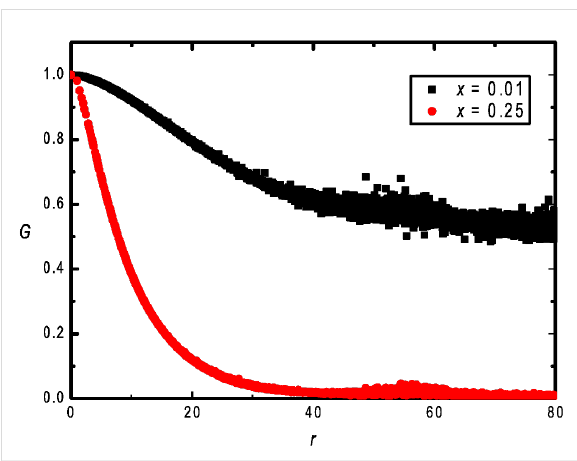
Figure 1: Nematic orientational correlation function G ( r ) for different values of x ( x = 0.01 and 0.25), N = 80 × 80 × 80, J LC–NP = − 1, J LC–LC = J NP–NP = 1.